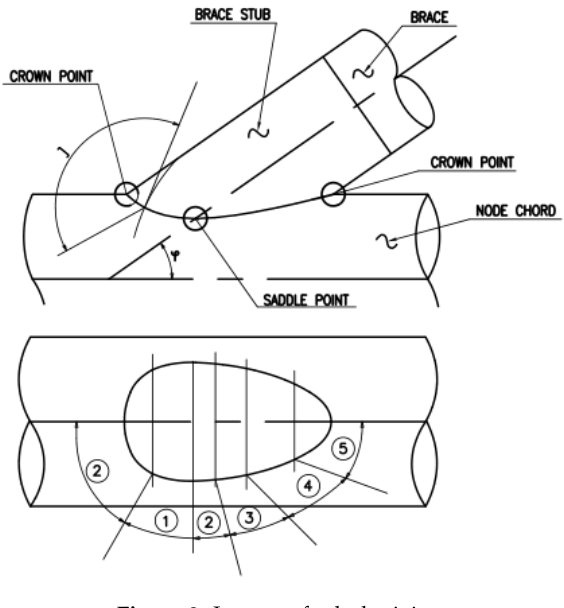
Figure 3. Layout of tubular joint. Figure 4. Layout of tubular joint.